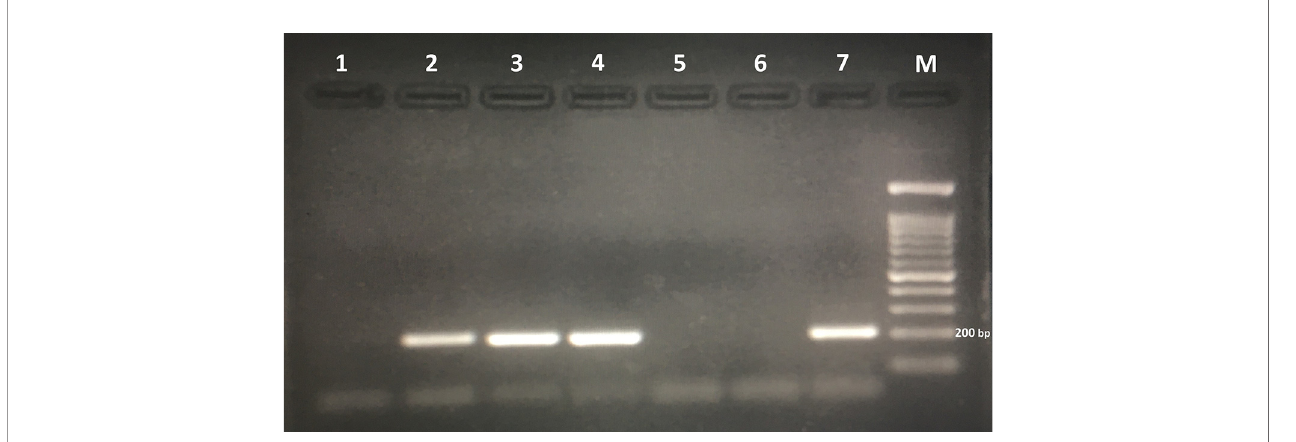
FIGURE 2 | Agarose gel electrophoresis of polymerase chain reaction products ampli fi ed with genomic DNA from stool samples. Lanes 2 , 3 , and 4 : polymerase chain reaction products of stool samples positive for Trichostrongylus spp. Lane 6 : negative control. Lane 7 : positive control ( Trichostrongylus colubriformis ). M , 100- bp DNA